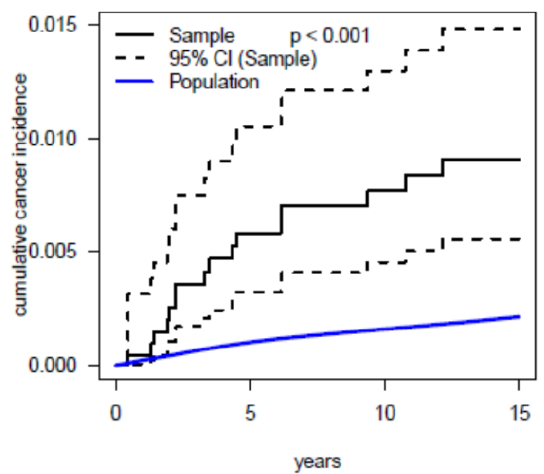
Figure 2. Cumulative incidence of cancer (solid black line) with 95% confidence intervals (dashed black lines) in 2770 patients having undergone cardiac catherization in the first year of life compared to expected cancer incidence (solid blue line), as derived from the German Childhood Cancer Registry.